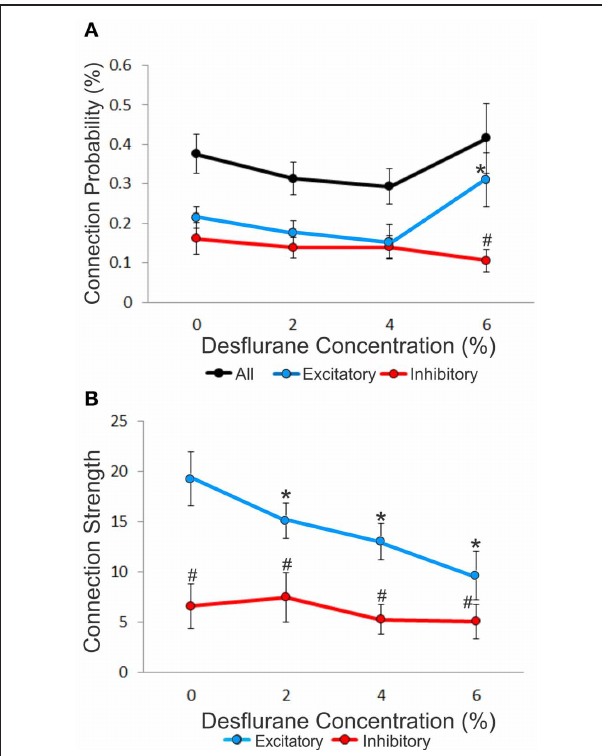
FIGURE 3 | Concentration-dependent effect of desflurane on connection probability and connection strength. (A) Effect of desflurane concentration on the percent connected over all possible connections. A significant difference on excitatory and inhibitory connections at 6% desflurane is observed, 3:1 (# p < 0 . 01, Tukey–Kramer). At 6% desflurane, significant increase in excitatory connection probability is observed from the 4% concentration level ( ∗ p < 0 . 05, Bonferroni). Data are represented as mean ± SEM. (B) Desflurane effect on connection strength. A significant linear decrease in excitatory connections strength ( ∗ p < 0 . 05, linear trend) with desflurane is present. A significant difference between the strength of excitatory and inhibitory connections is present at all desflurane concentrations (# p < 0 . 001, RM-ANOVA). Data are represented and mean ± SD.